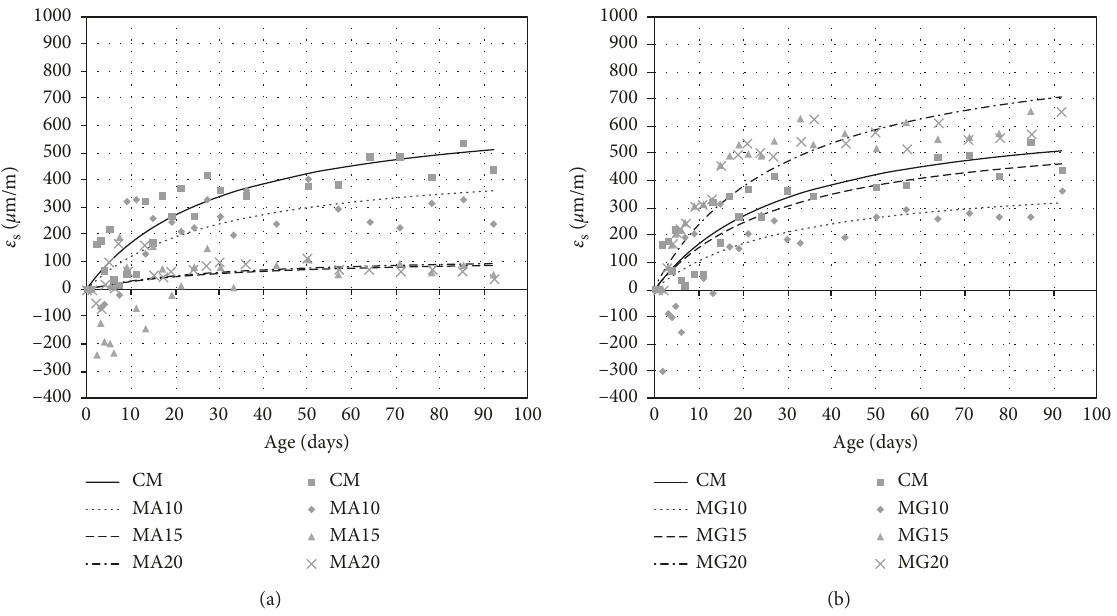
Figure 9: Shrinkage of mortars with (a) MgO A (MA) and (b) MgO G